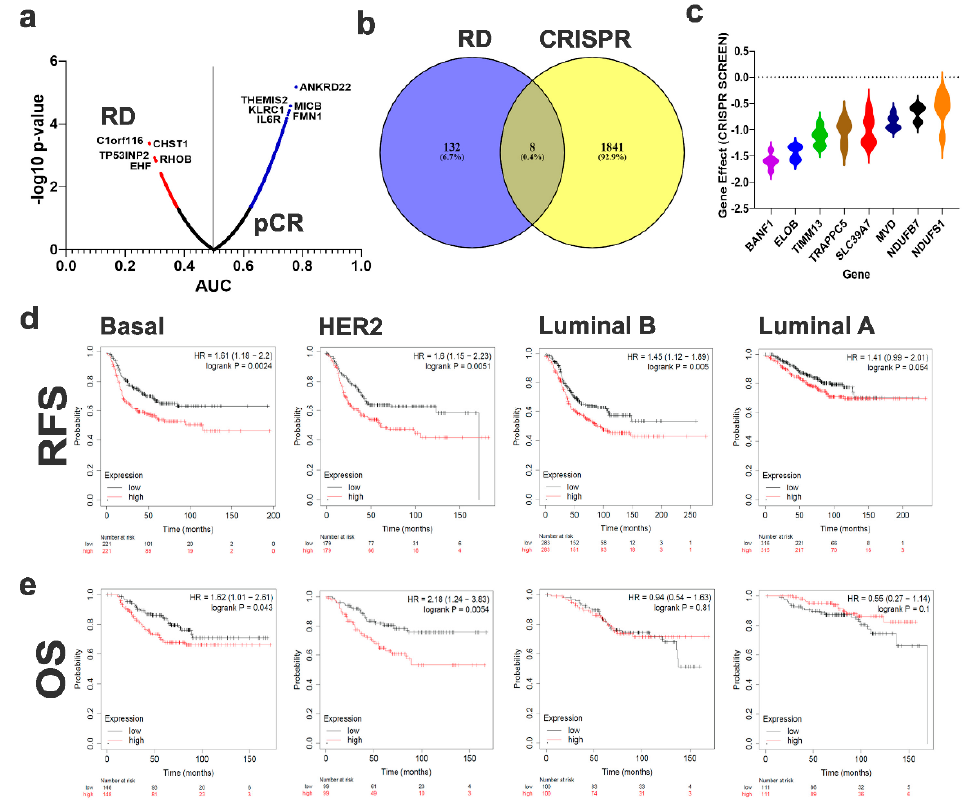
Figure 2. Identification of predictive mRNA panels to discriminate RD from pCR TNBC. ( a ) mRNA transcriptome data were subjected to ROC analysis. Data are presented as a volcano plot where the x -axis represent the AUC and the y -axis represent the − log10 p -value. mRNAs with significant ( p < 0.05) prediction power of RD are labeled in blue, while those predictive of pCR are colored red. ( b ) Venn diagram representing the common genes between mRNAs predictive of RD from the discovery cohort and the gene effects (< − 0.5) from a CRISPR-Cas9 screen on TNBC cell models from the Achille project. ( c ) Violin plot illustrating the gene effects of the eight identified mRNAs in a panel of TNBC cell models (BT549, MDA-MB-157, HCC70, MDA-MB-231, MDA-MB-468, MDA-MB-453) based on data from the Achille project. RFS ( d ) and OS ( e ) analysis of the eight gene signature in an independent cohort of Basal, HER2+, Luminal B, and Luminal A breast cancer patients.